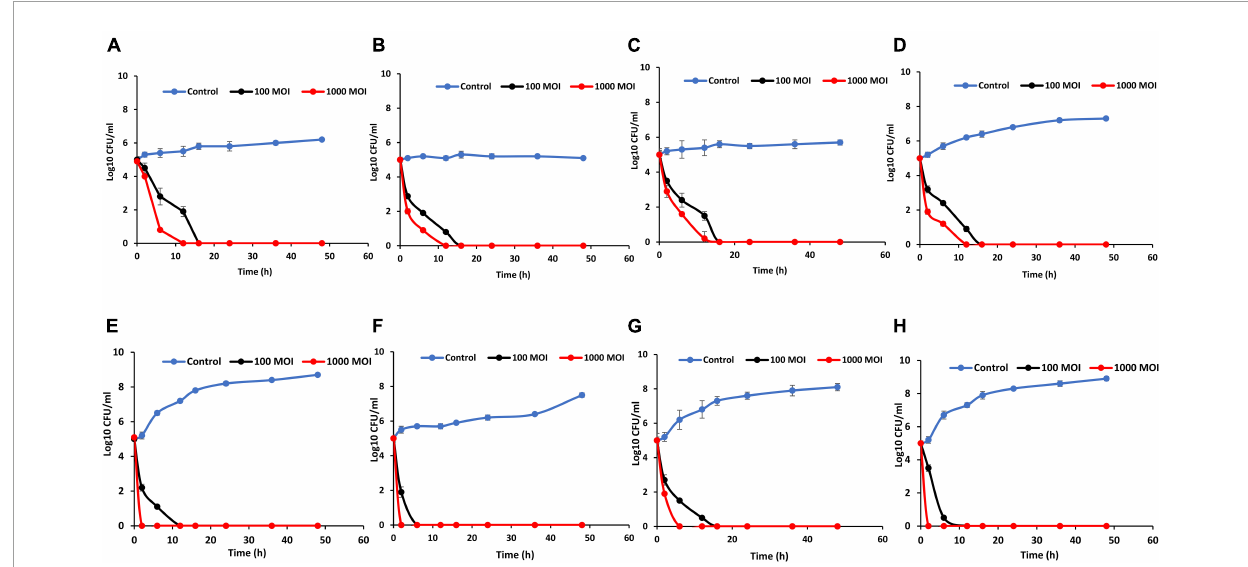
FIGURE9 Effectiveness of phage LPSent1 in reducing the S . Enteritidis EG.SmE1 in milk, water, apple juice, and on chicken breasts at either 4 ◦ C or 25 ◦ C. (A,E) Application in milk at 4 ◦ C or 25 ◦ C respectively, (B,F) application in water at 4 ◦ C or 25 ◦ C respectively, (C,G) application in apple juice at 4 ◦ C or 25 ◦ C respectively, and (D,H) application on chicken breasts at 4 ◦ C or 25 ◦ C respectively. Phage LPSent1 was applied at two different MOIs (100 and 1,000) to each food article and incubated for 48 h at either 4 ◦ C or 25 ◦ C. Bacterial load was estimated at different time points by measuring the mean CFU/mL ± standard deviation of three replicates of each time